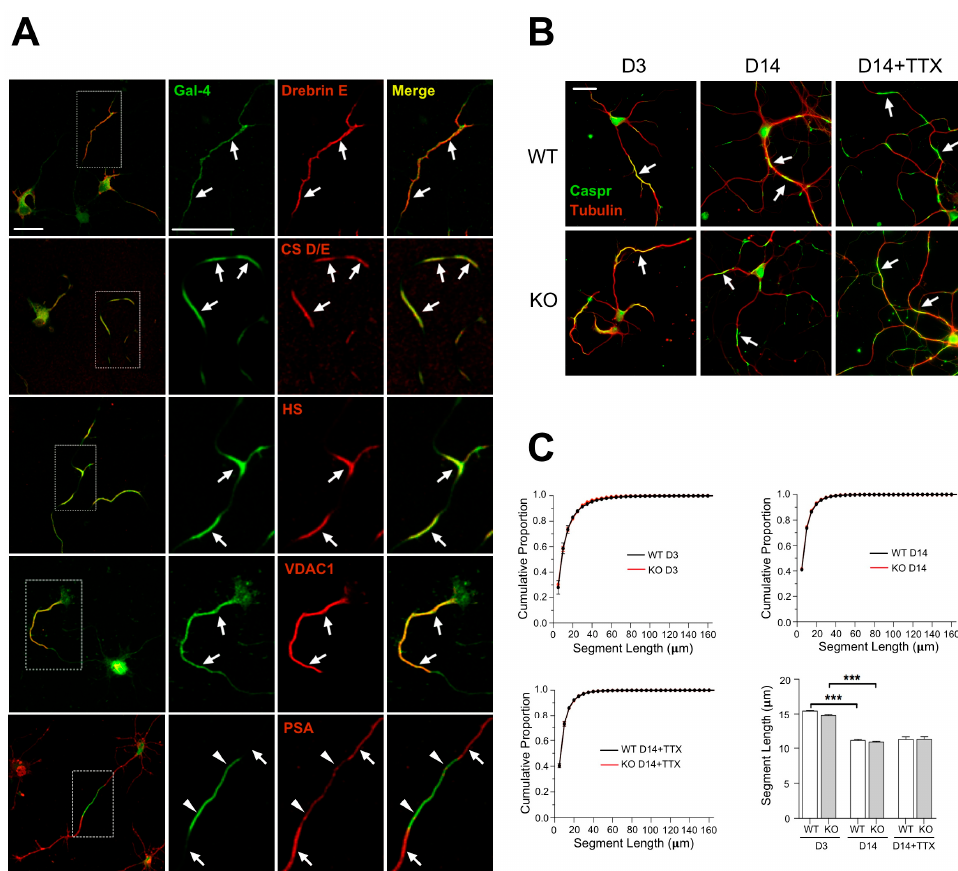
Figure 1. ( A ) Components of the NMS corroborated by IF. Rat cortical neurons in culture, analyzed by double immunofluorescence under non-permeabilizing conditions for the NMS marker Gal-4 and the indicated molecules (Supplementary Table S1). NMS are indicated by arrows. Magnified ROIs are indicated by dotted line boxes in the left column. Caspr and contactin are not shown as they have been associated with NMS in former reports [21]. PSA-NCAM is an example of expression in axonal segments alternative to NMS (arrowheads in bottom panels). ( B ) Cortical neurons from WT (top row) and Lgals4-KO (bottomrow) mice, sequentially immunostained against Caspr (green) before permeabilization and against β 3-tubulin (red) after permeabilization. The length of the NMS expressing Caspr was measured at 3 and 14 DIV, or at 14 DIV after 7 days treatment with TTX (D14+TTX). NMS are indicated by arrows. ( C ) Cumulative proportion distributions of the NMS lengths at 3 and 14 DIV (D3 and D14, respectively), or at 14 DIV after 7 days treatment with TTX (D14+TTX). A two-way ANOVA followed by Tukey post hoc test showed no significant differences. Bottom-right bar graph displays NMS length at the same times and treatment in culture. Data are means + SEM (n = 3 independent experiments, 6074 to 45360 NMS were measured; *** p > 0.001). (Scale bars are 20 µ